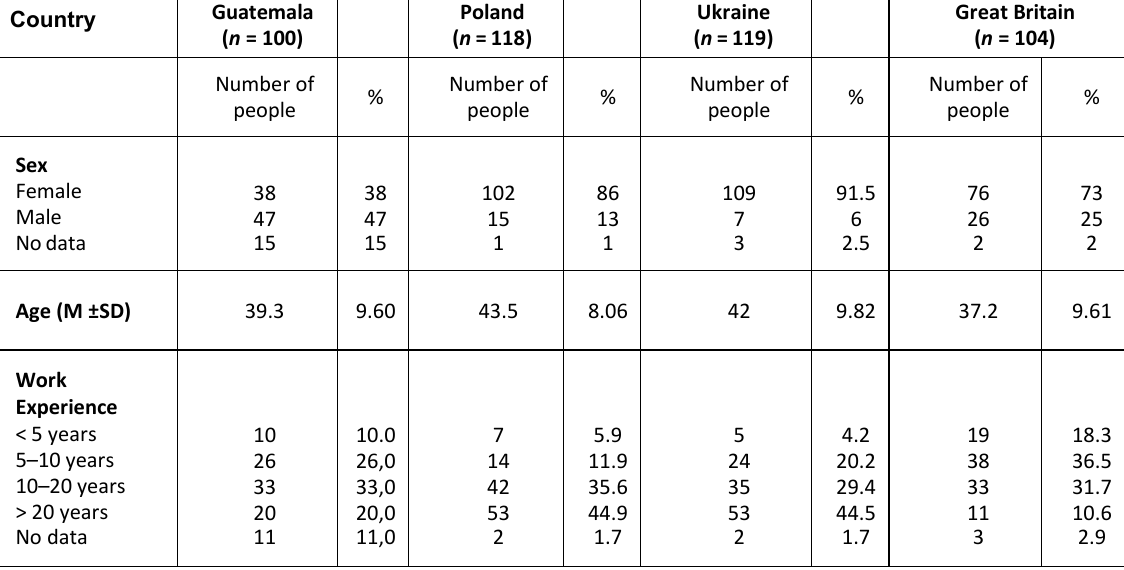
Table 1. Sociodemographic Characteristics of the